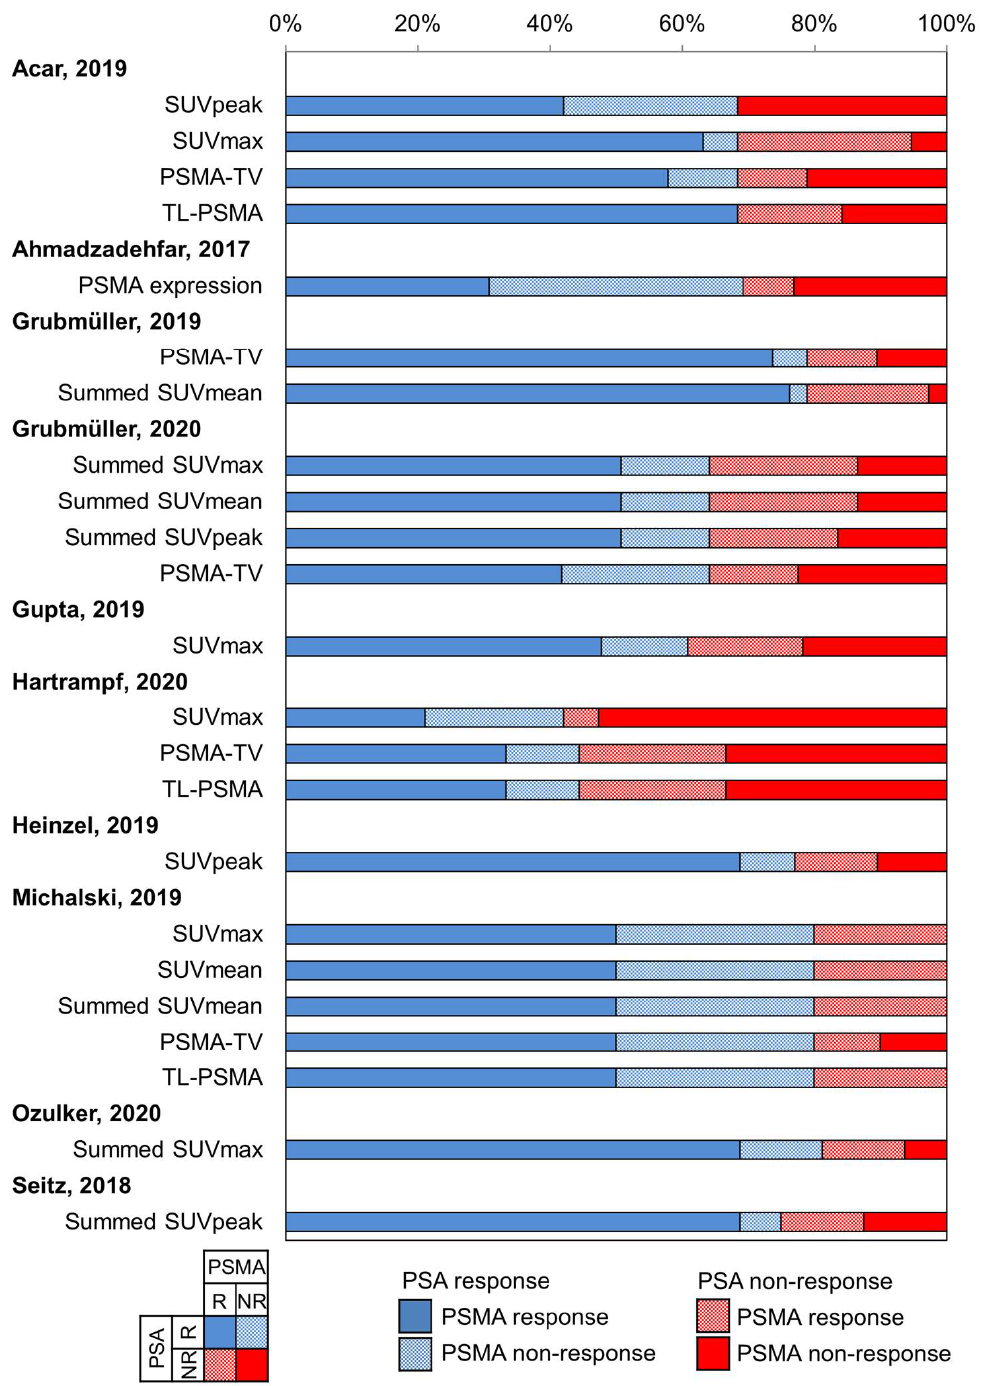
Figure 3. Breakdown of prostate-specific antigen (PSA) and prostate-specific membrane antigen positron emission tomography (PSMA PET) response assessment. NR = non-response; PSMA-TV = PSMA tumor volume; R = response; SUV = standardized uptake value; TL-PSMA = total lesion PSMA